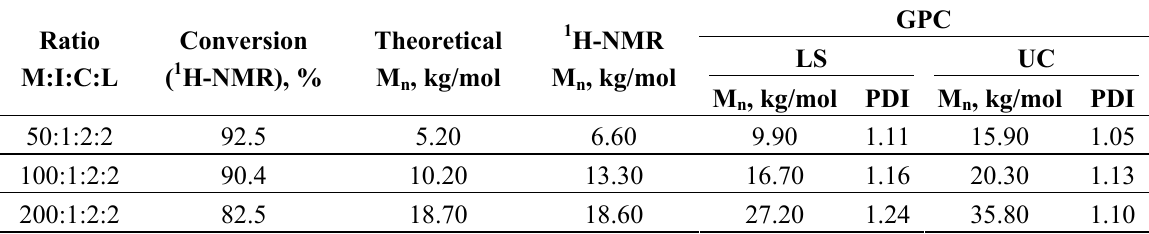
Table 1. Comparison between theoretical and molecular weights of PNIPAAm found by